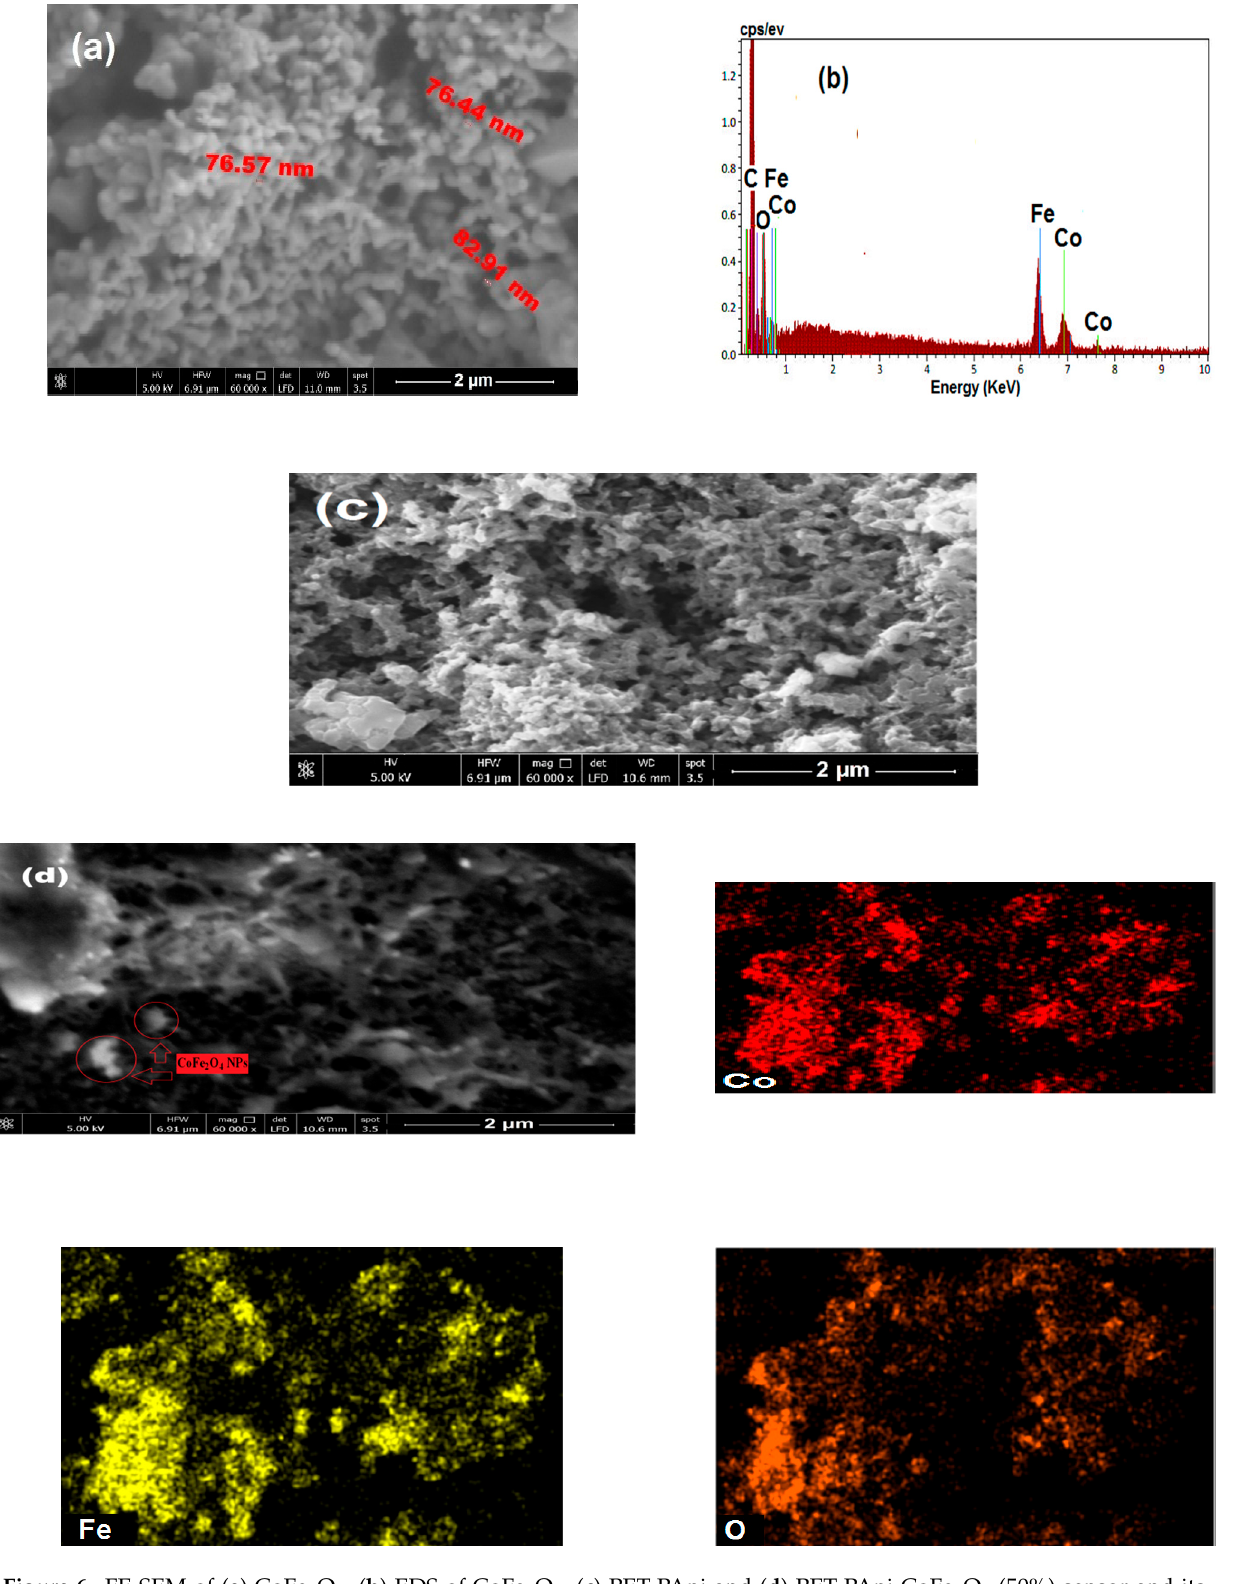
Figure 6. FE-SEM of ( a ) CoFe 2 O 4 , ( b ) EDS of CoFe 2 O 4 , ( c ) PET-PAni and ( d ) PET-PAni-CoFe 2 O 4 (50%) sensor and its elemental mapping images of the Co (red), Fe (yellow) and O (brown)